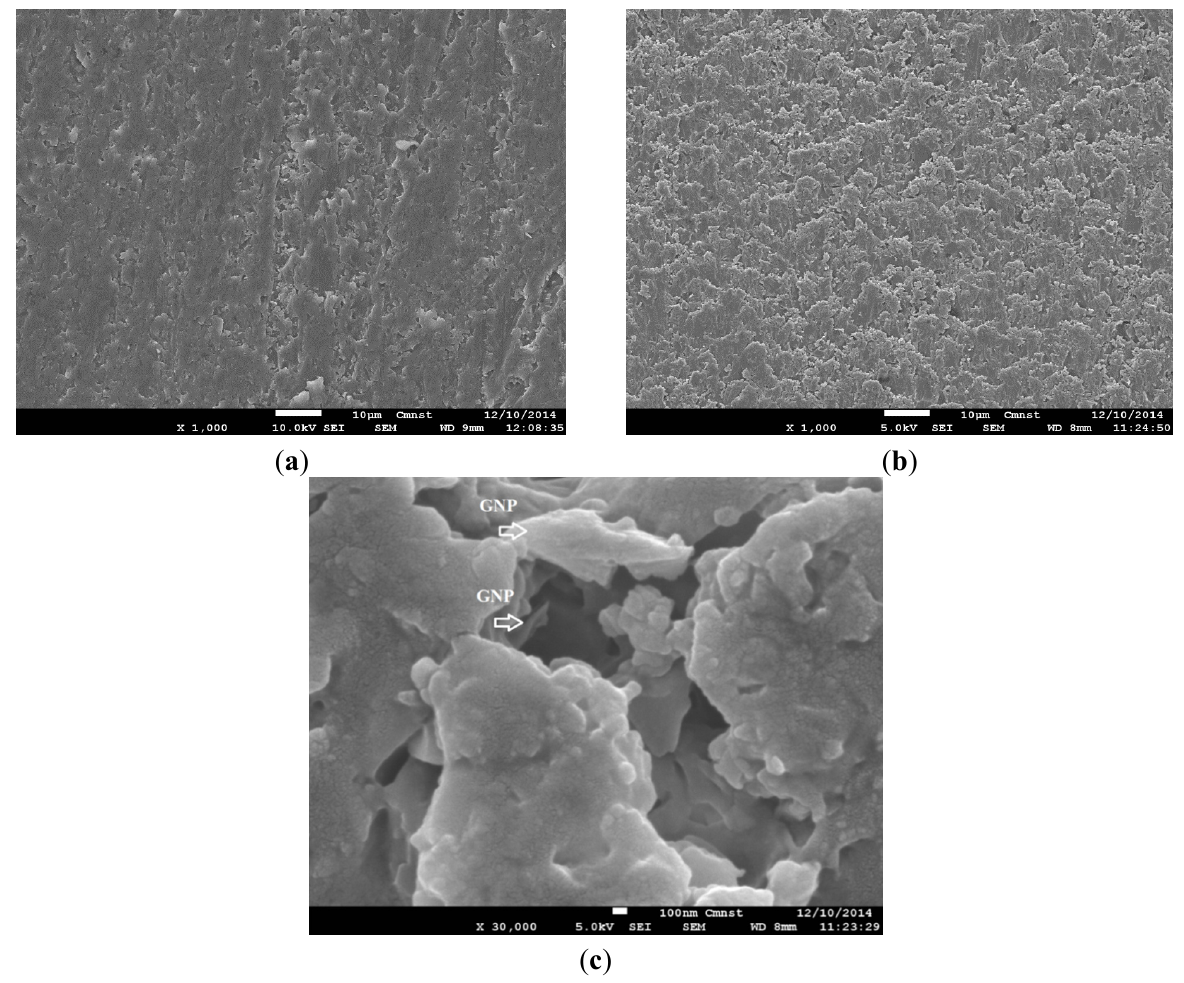
Figure 9. SEM graphs of ( a ) neat epoxy/polyester; ( b ) epoxy/polyester composite reinforced with 0.2% GNPs at a magnification of 1,000; ( c ) epoxy/polyester composite reinforced with 0.2% GNPs at a magnification of 30,000.